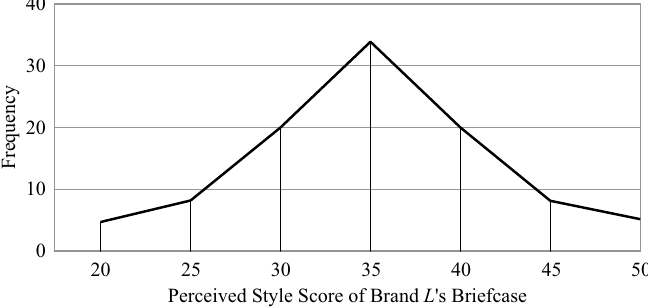
Fig. 5. Histogram manipulation of brand L in condition 3